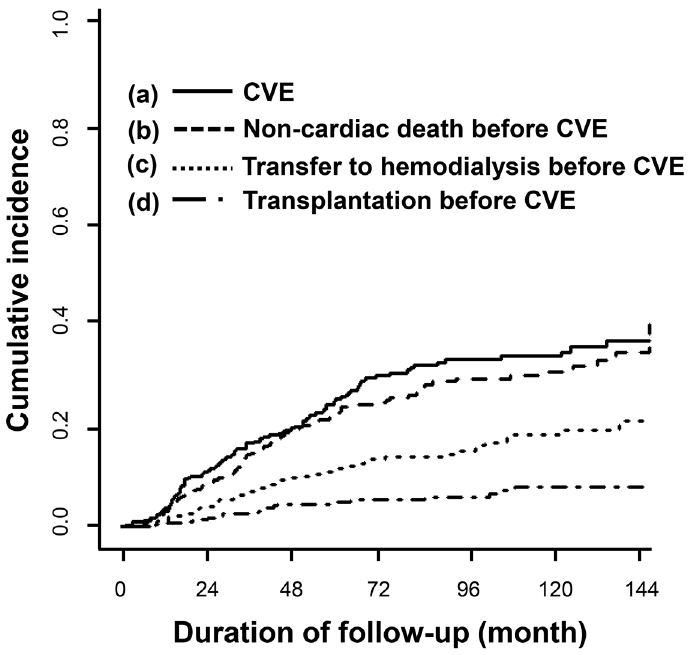
Fig 2. The cumulative incidence curves for a new-onset cardiovascular event and other outcomes. CVE, cardiovascular